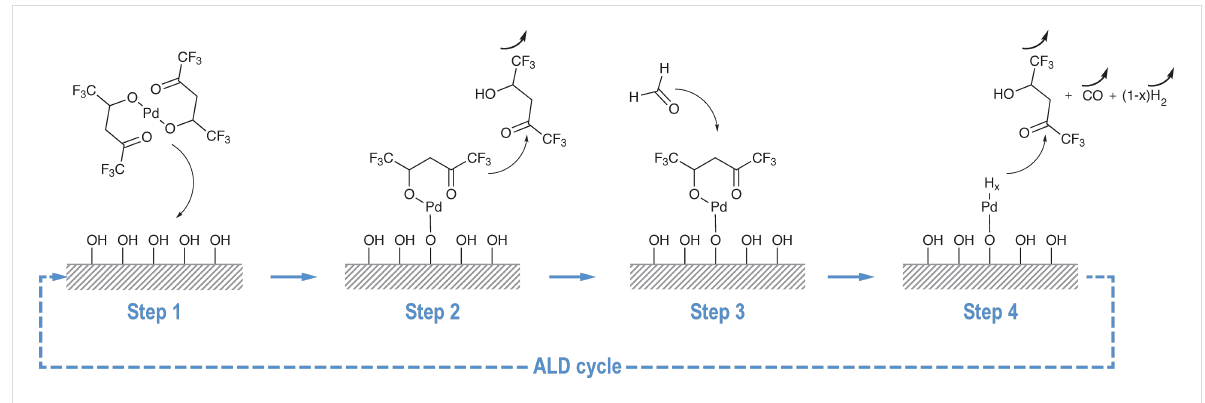
Figure 7: ALD sequence during Pd deposition from Pd(hfac) 2 and formaldehyde.